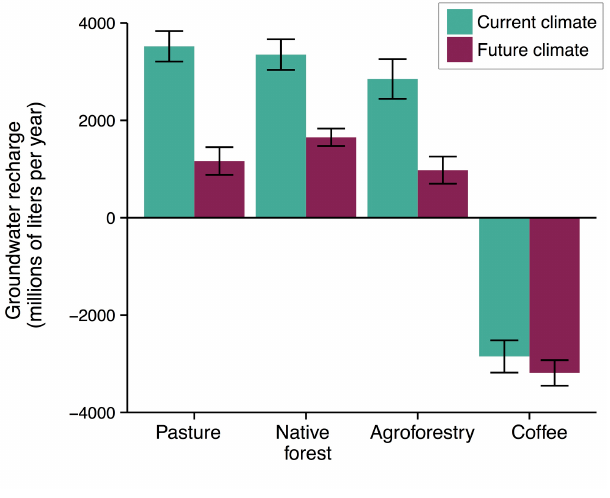
Fig. 2. Groundwater recharge (rainfall + fog interception - ET) in millions of liters per year under the current climate and a future climate (RCP 8.5 midcentury) under different land-use scenarios. Error bars = one standard deviation of error associated with ET